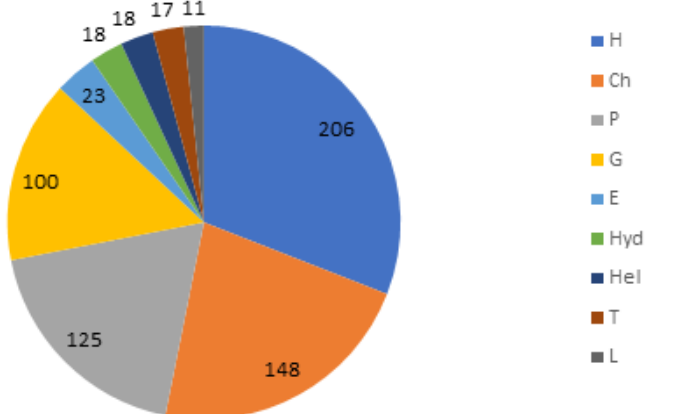
Figure 5. Number of species according to their biological form (principal ranks), according to the classification of Rivas-Martínez (2004). H: Hemicryptophyte, Ch: